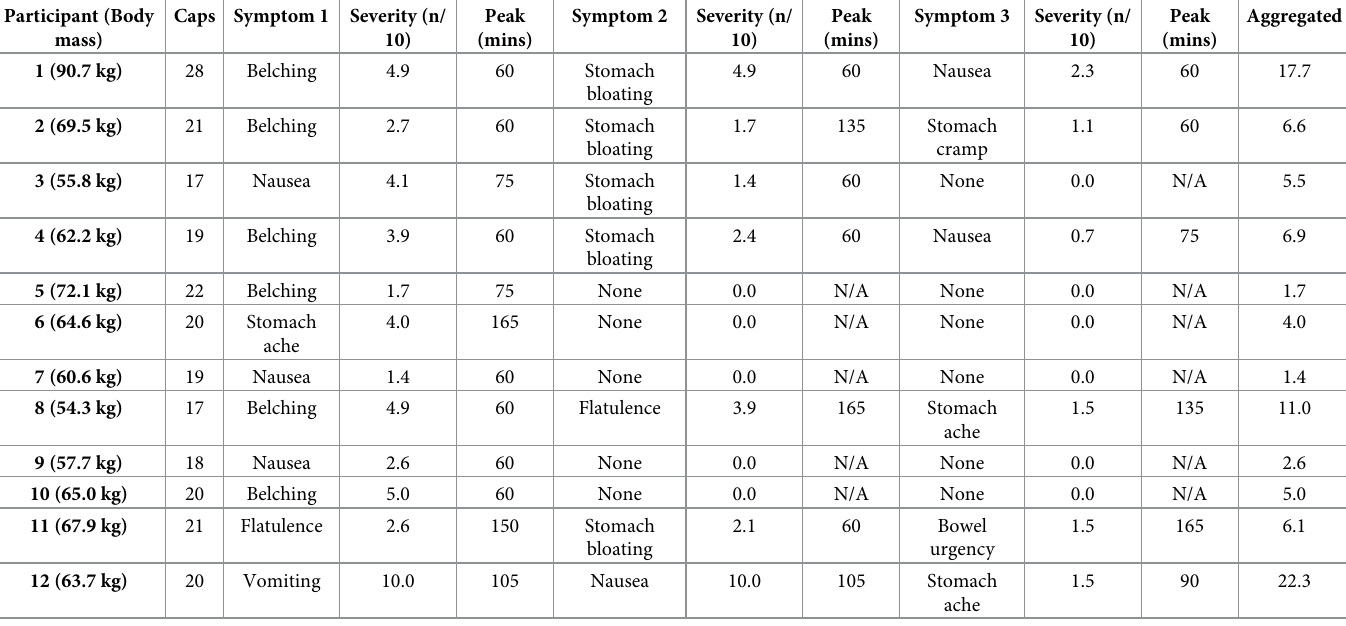
Table 5. The three most severe symptoms of gastrointestinal discomfort experienced following the ingestion of 0.3 g � kg BM -1 sodium bicarbonate (NaHCO 3